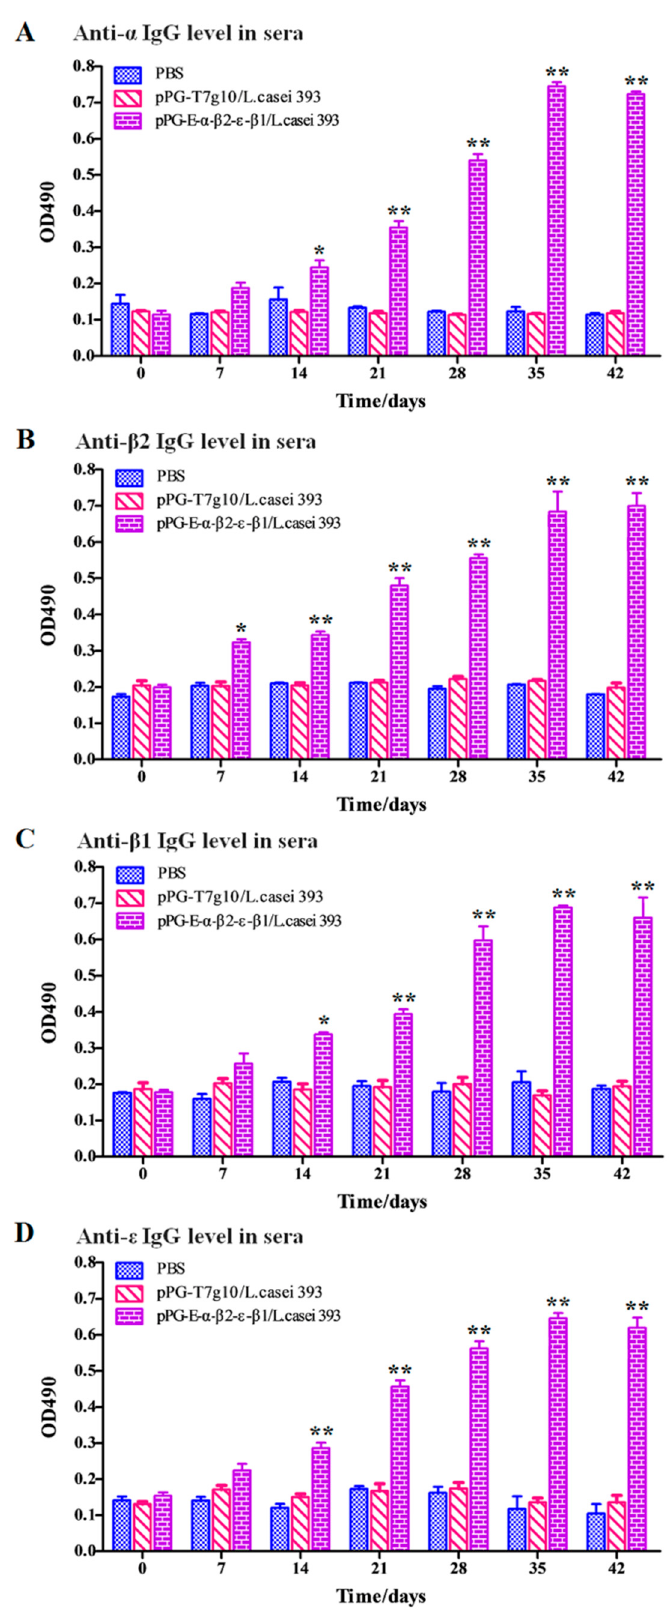
Figure 5. The levels of antigen-specific IgG antibody in serum samples of rabbits were determined using ELISA at different time points after the primary immunization with the bait particle vaccine. ( A ) Anti- α IgG level in sera; ( B ) Anti- β2 IgG level in sera; ( C ) Anti- β1 IgG level in sera; ( D ) Anti- ε IgG level in sera. The results are presented as mean ± SD in each group (* p < 0.05, ** p < 0.01).